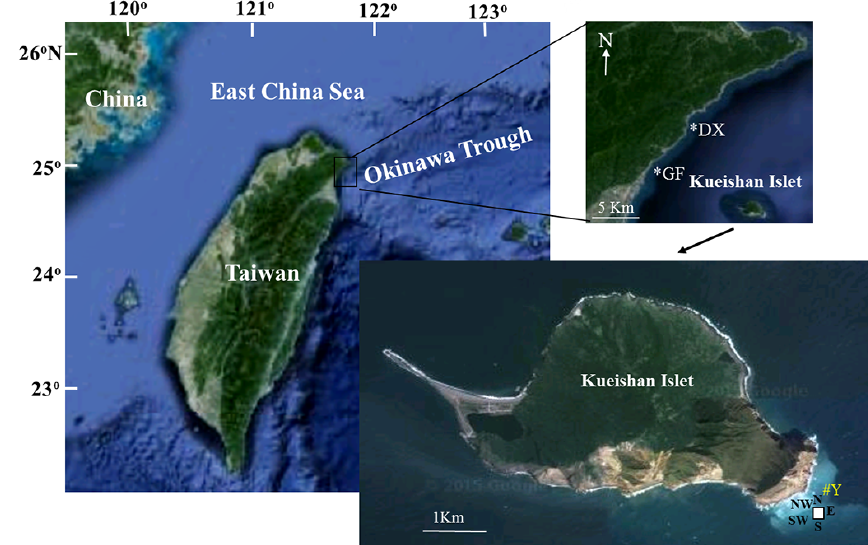
Figure 1. Map showing the sampling sites. *DX: Euplica sp. sampling site at Da-xi (24.9413 ◦ N, 121.90390 ◦ E); *GF: Euplica sp. sam- pling site at Geng-fang (24.9046 ◦ N, 121.87200 ◦ E); (cid:3) : Anachis misera from the white vent (24.8341 ◦ N, 121.96196 ◦ E); #Y: yellow vent (24.8355 ◦ N, 121.96371 ◦ E); N: north; E: east; S: south; SW: southwest; NW: northwest (Source: Google